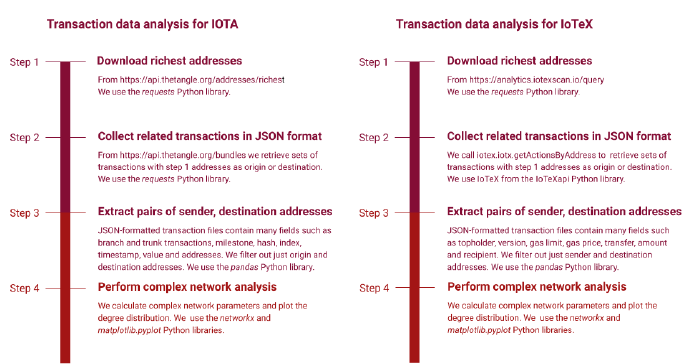
Figure 6. Tx degree distribution in BTC and ETH.